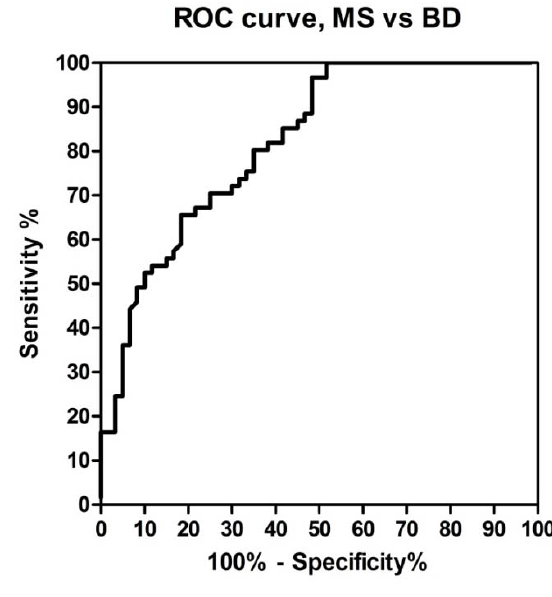
Figure 3. ROC curve analysis of antibodies to CSF114(Glc) in MS vs . BD determined by SPR. The area under the curve is 0.82 (p < 0.0001). Cut-off was set at 105 RU with a sensitivity of 36%, a specificity of 95%, and a positive likelihood ratio of